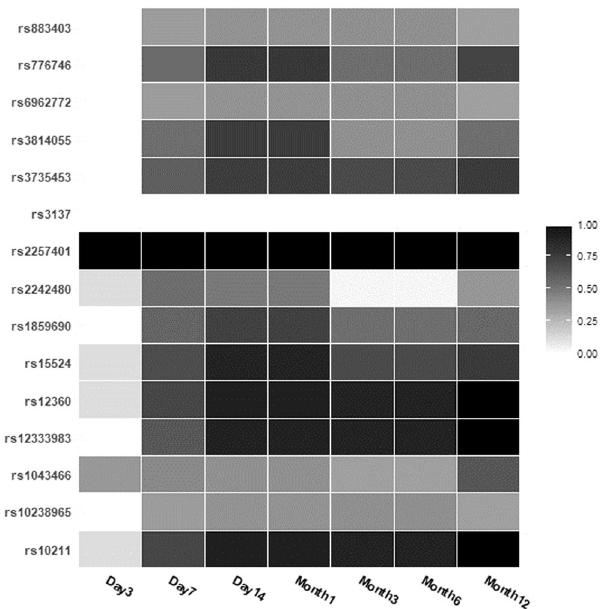
Figure 2. Heat map plots of variants commonly associated with dose-adjusted tacrolimus trough concentrations from day 3 to 1 year after transplantation. The color was scaled based on an adjusted P value of variants associated with tacrolimus trough levels (black, highly significant association; white, no significant